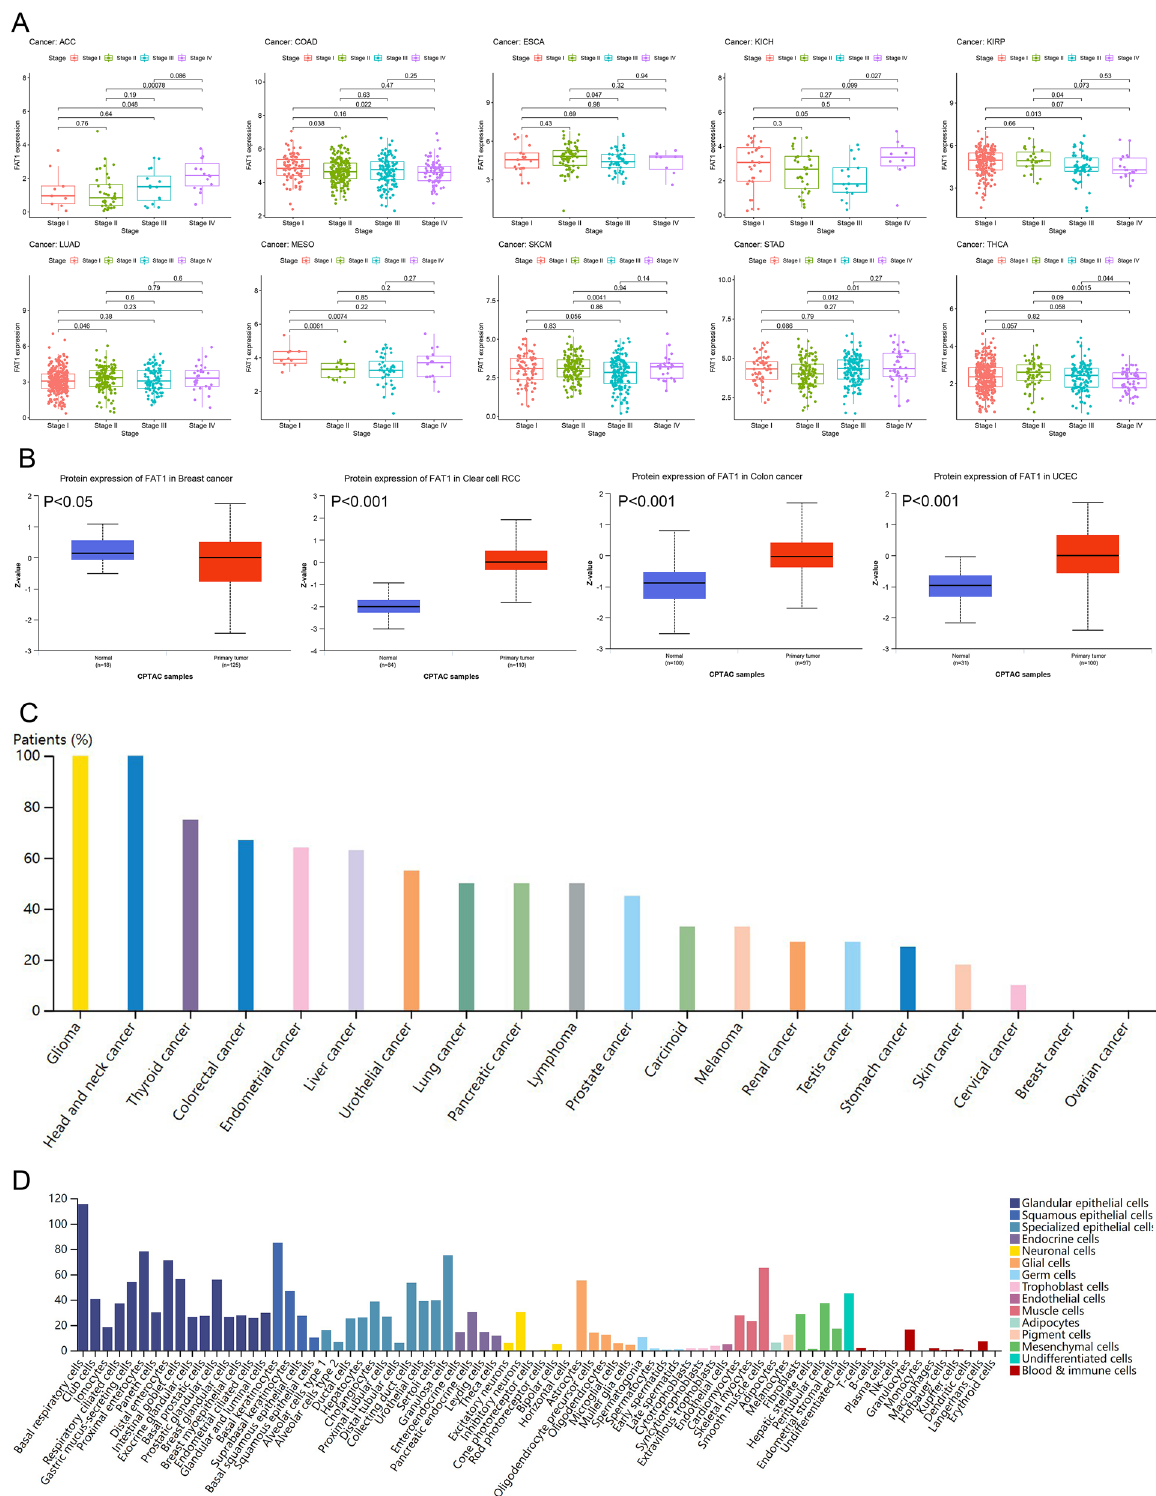
Figure 2. FAT1 multi-omics expression. ( A ) FAT1 mRNA levels in pan-cancer with differential expression at different stages. ( B ) Based on CPTAC data, FAT1 protein is expressed at low levels in breast cancer and highly expressed in clear cell renal cell carcinoma, colon cancer, and uterine corpus endometrial carcinoma. ( C ) Immunohistochemical summary histogram of FAT1 in pan-cancer based on The Human Protein Atlas, different colors represent different tumors. ( D ) Expression levels of FAT1 in 12 single cell types based on The Human Protein